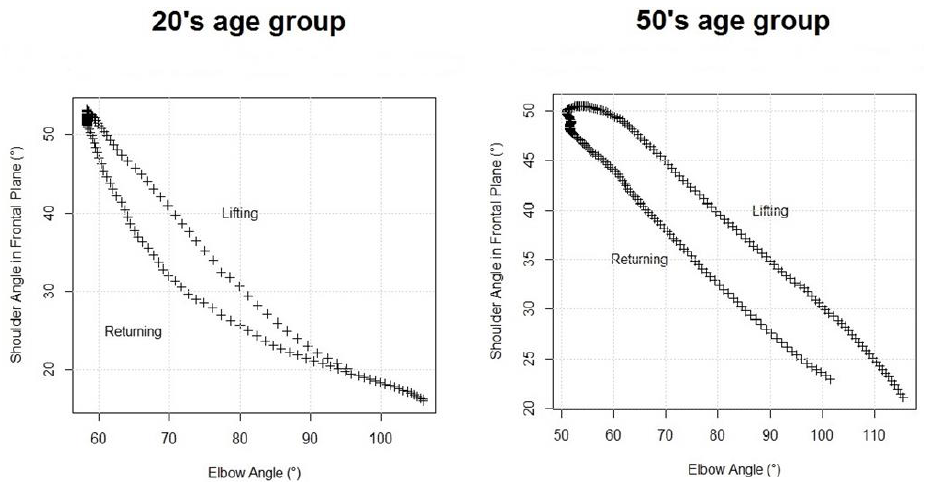
Figure 5. Interjoint coordination for the shoulder and elbow joint angle movements during touching of contralateral shoulder for normal subjects by age